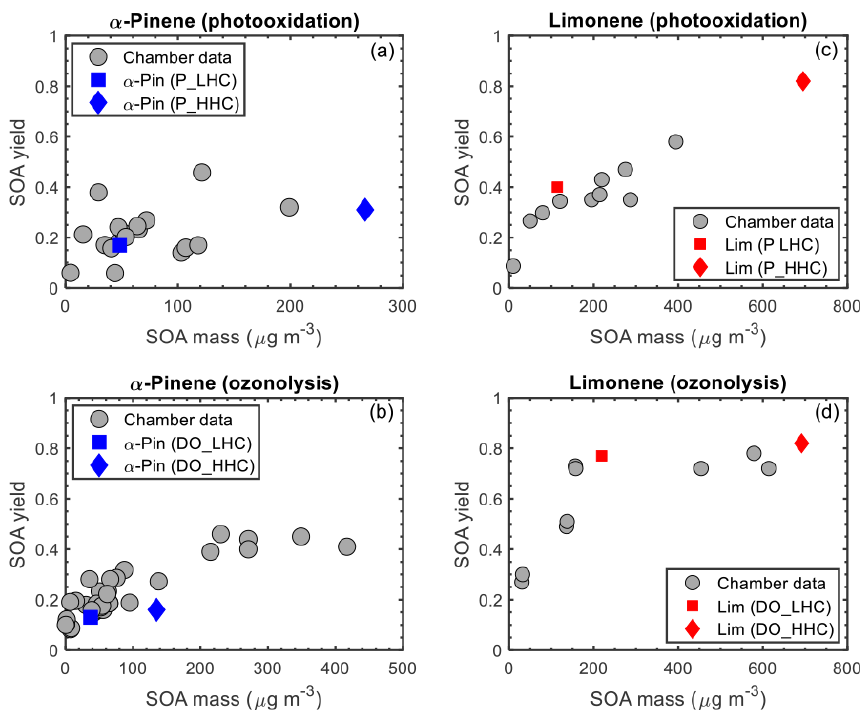
Figure 4. GECKO-A SOA yields are represented by blue ( α -pinene) and red (limonene) markers; chamber SOA yields are represented by grey markers. The initial hydrocarbon mixing ratios are differentiated by shape: squares represent the simulation using the lower hydrocarbon (LHC) mixing ratio and diamonds the simulation using the higher hydrocarbon (HHC) mixing ratio. Table 3. Simulation-based OH exposure, simulated average mass-weighted O / C ratio, and chamber average mass-weighted O / C ratio for α -pinene and limonene under photooxidation and ozonolysis